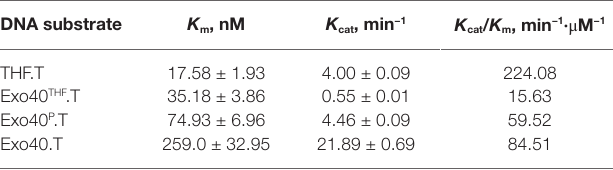
TABLE 1 | Steady state kinetic parameters of DrXth with different DNA substrates. DNA